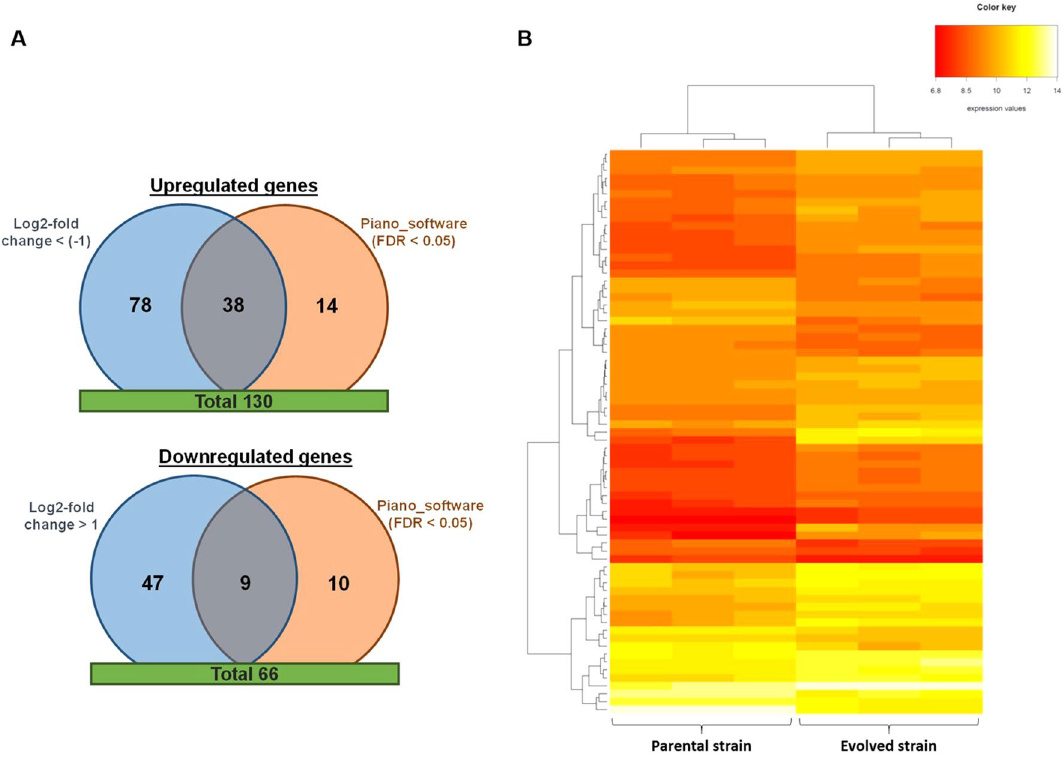
Figure 4. Differential expression analysis between parental and evolved S. cerevisiae F12 in terms of ( A ) induced and repressed genes and ( B ) hierarchical clustering. Piano Software [http:// biomet- toolb ox. chalm ers.